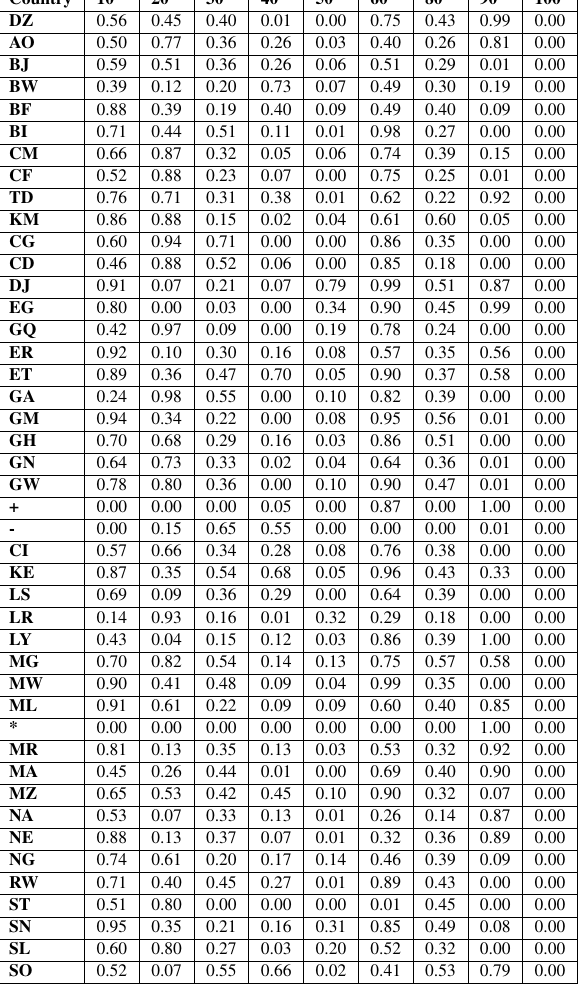
This contribution has been peer-reviewed. https://doi.org/10.5194/isprs-archives-XLIII-B4-2020-707-2020 | © Authors 2020. CC BY 4.0